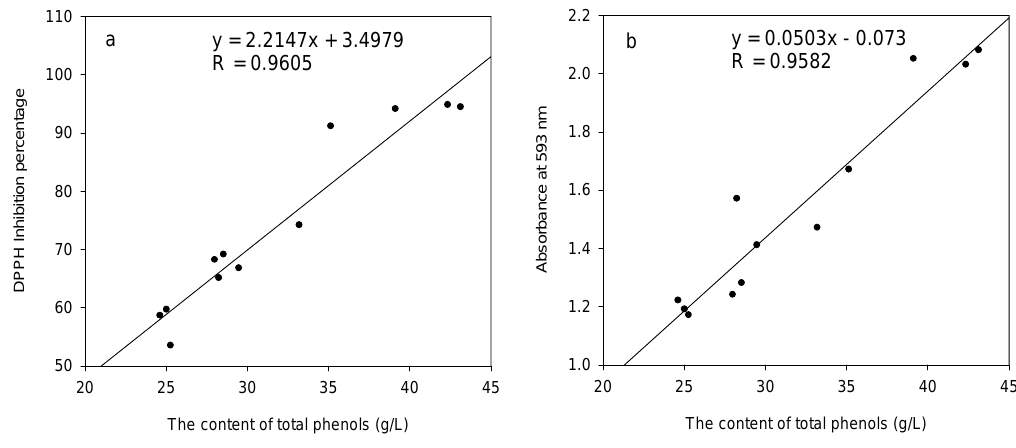
Figure 2. Relationships between the total phenolic content and the free radical scavenging activity (a); the total phenolic content and the ferric-reducing power (b) of the 50% ethanol-water extracts of A. mangium